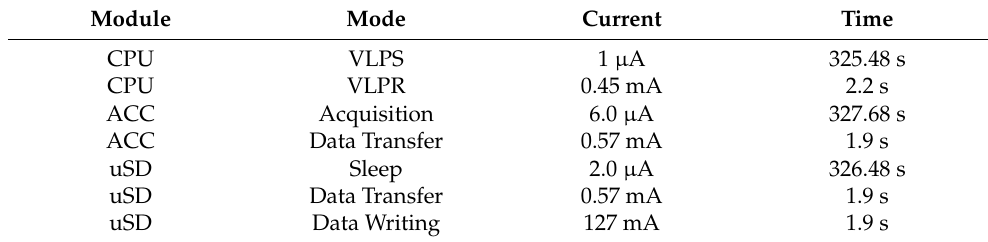
Table 2. The power consumption of the worst-case